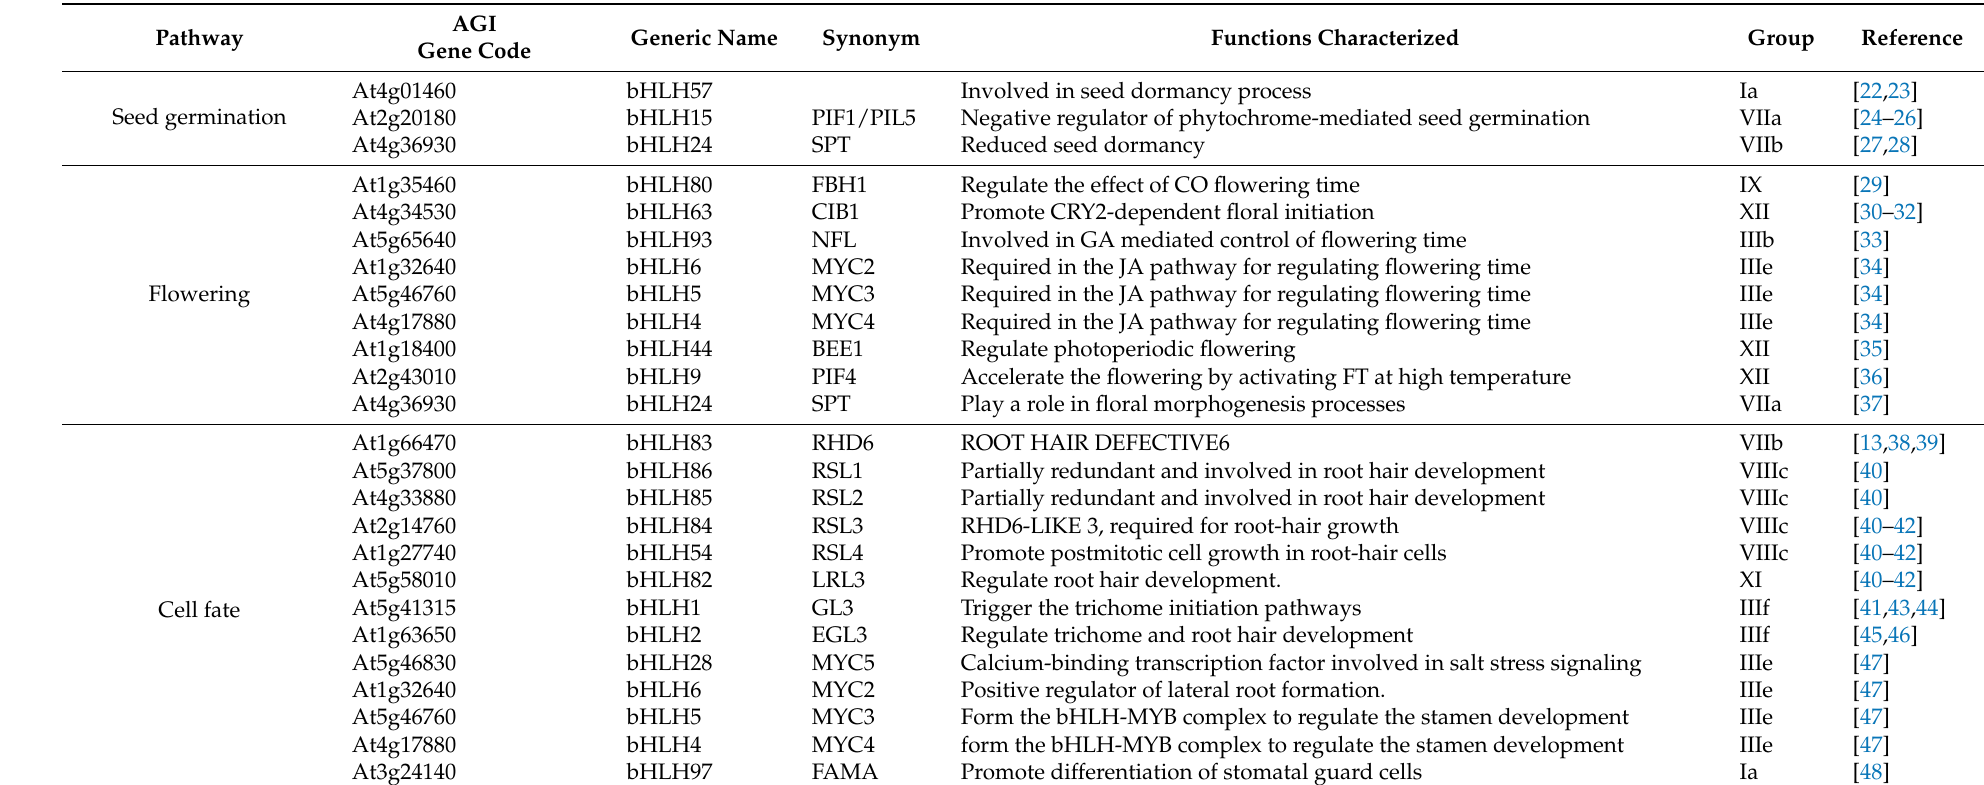
Table 1. Functional characterized bHLH protein